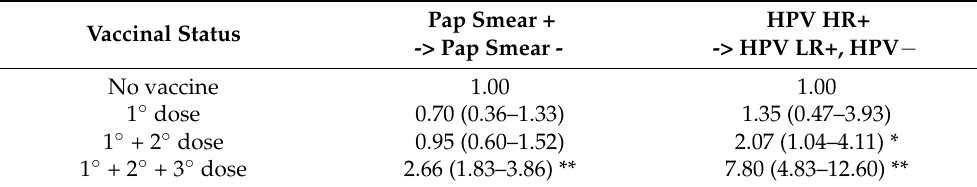
Table 2. Comparison of univariate Cox regression model results for positive Pap smear versus HPV HR+ negativization. Vaccinal